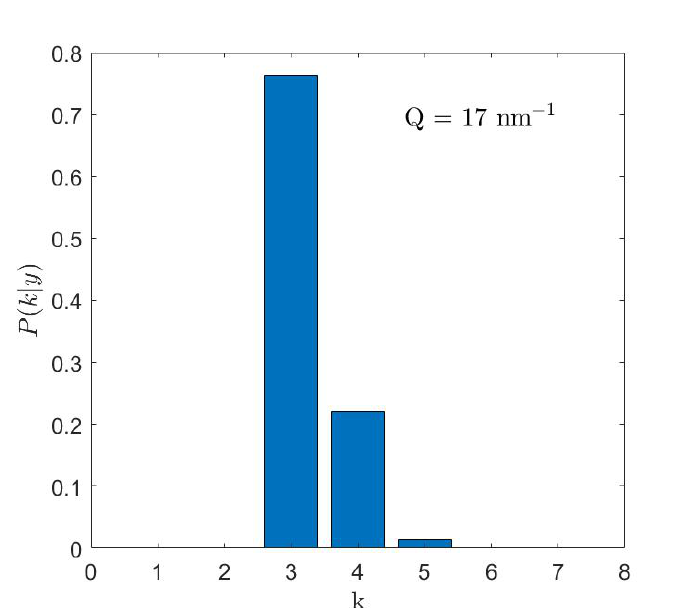
Figure 8. Simulated posterior distribution for the number, k , of inelastic components given the experimental data y for the frozen suspension of AuNPs at a momentum transfer of Q = 17 nm − 1